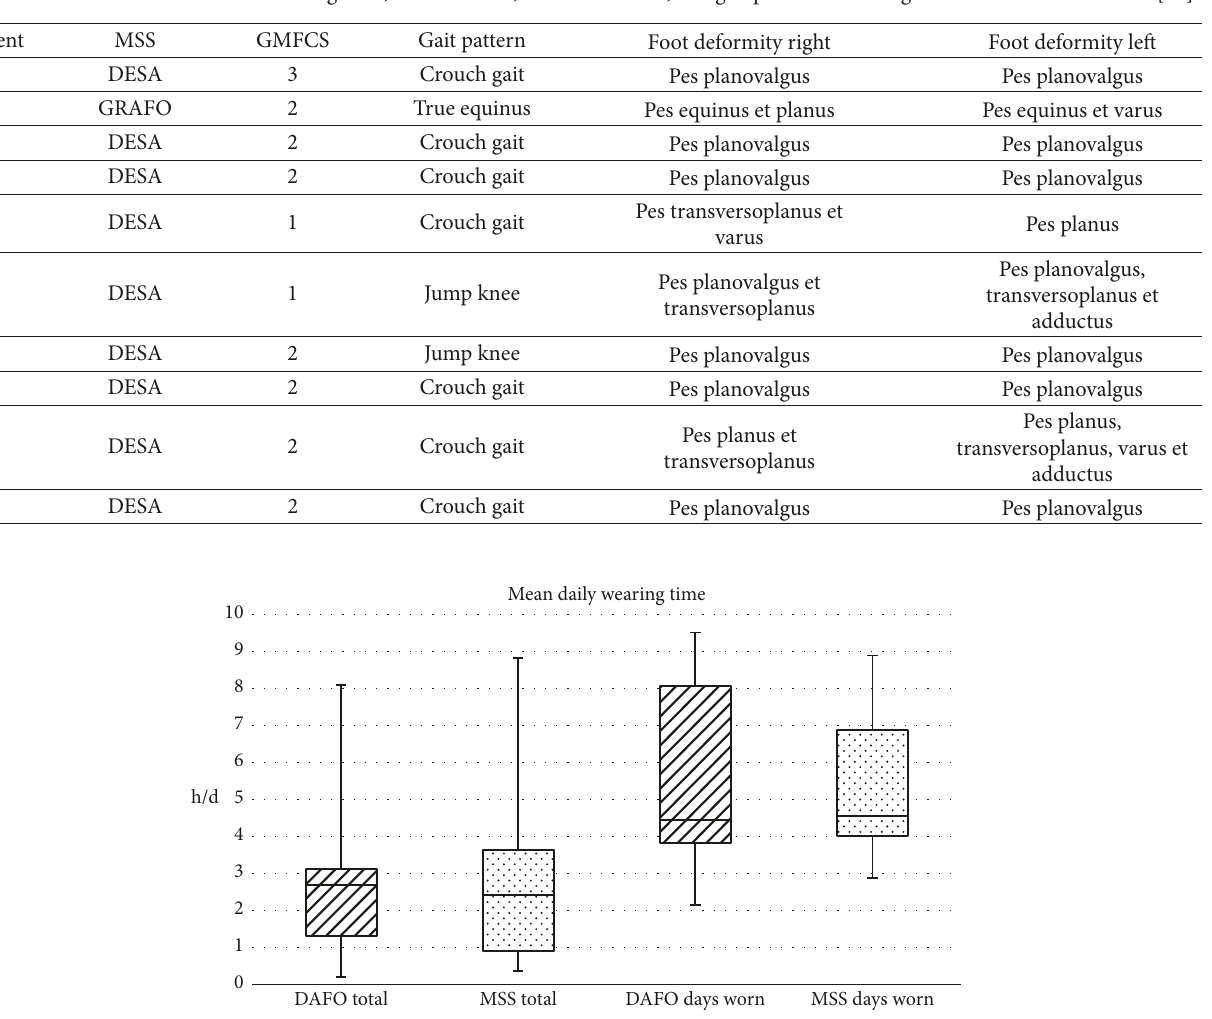
Table 1: Patients’ characteristics including MSS, GMFCS level, foot deformities, and gait pattern according to the Rodda classification [30].